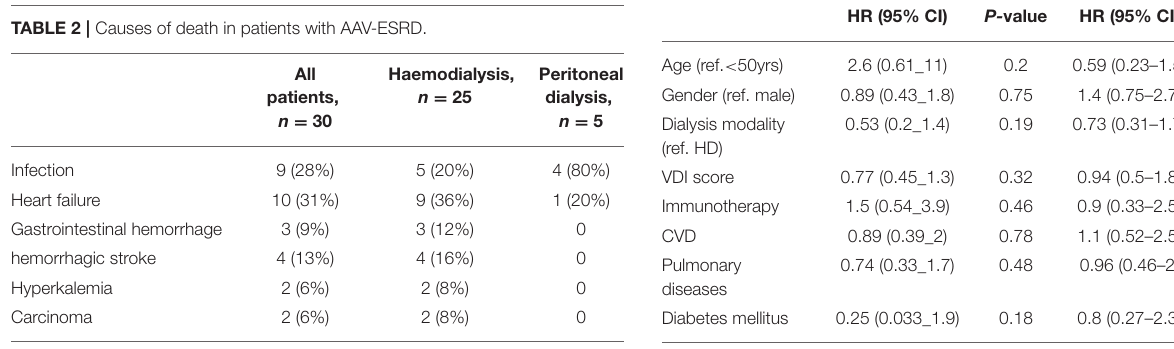
TABLE 3 | Predictors for death of AAV-ESRD patient with long-term dialysis. Variables